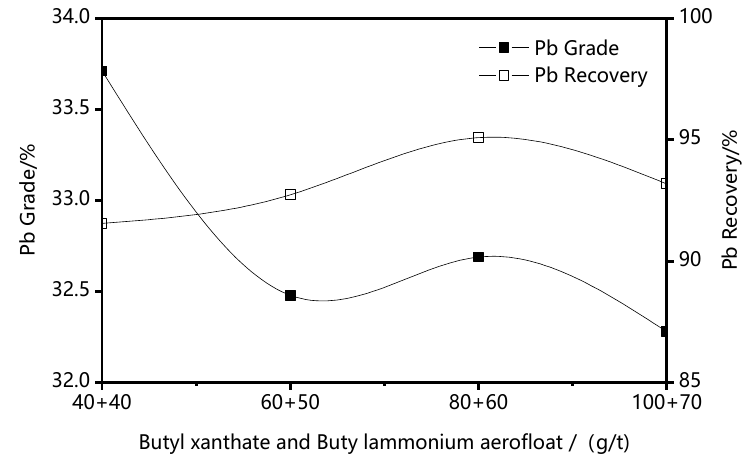
Figure 10. The influence of butyl xanthate and butyl ammonium aerofloat dosage on Pb rougher flotation.